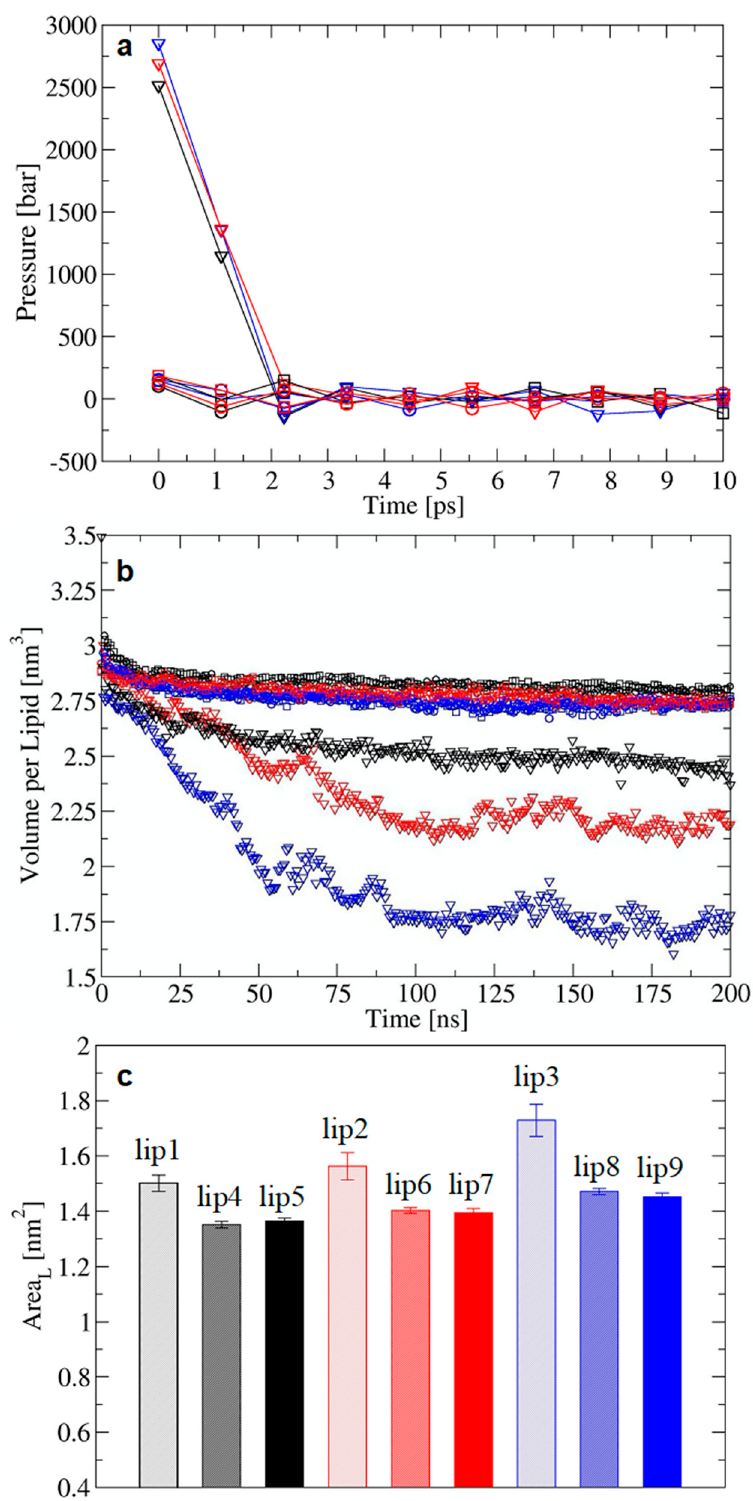
Figure 3. The effect of the equilibration protocols on the initial pressure and structural properties of lipid-A membranes in the presence of Al 3+ counterions without additional salts (black), 150 mM of AlCl 3 (red), and 150 mM of NaCl (blue). ( a ) Initial pressure for equilibration with NPT-only (triangles) and stepwise-thermalization NVT/NPT using reaction field (squares) or PME (circles). ( b ) Volume per lipid, V L . ( c ) Area per lipid, A L . Averages were calculated over the last 100 ns of simulation.